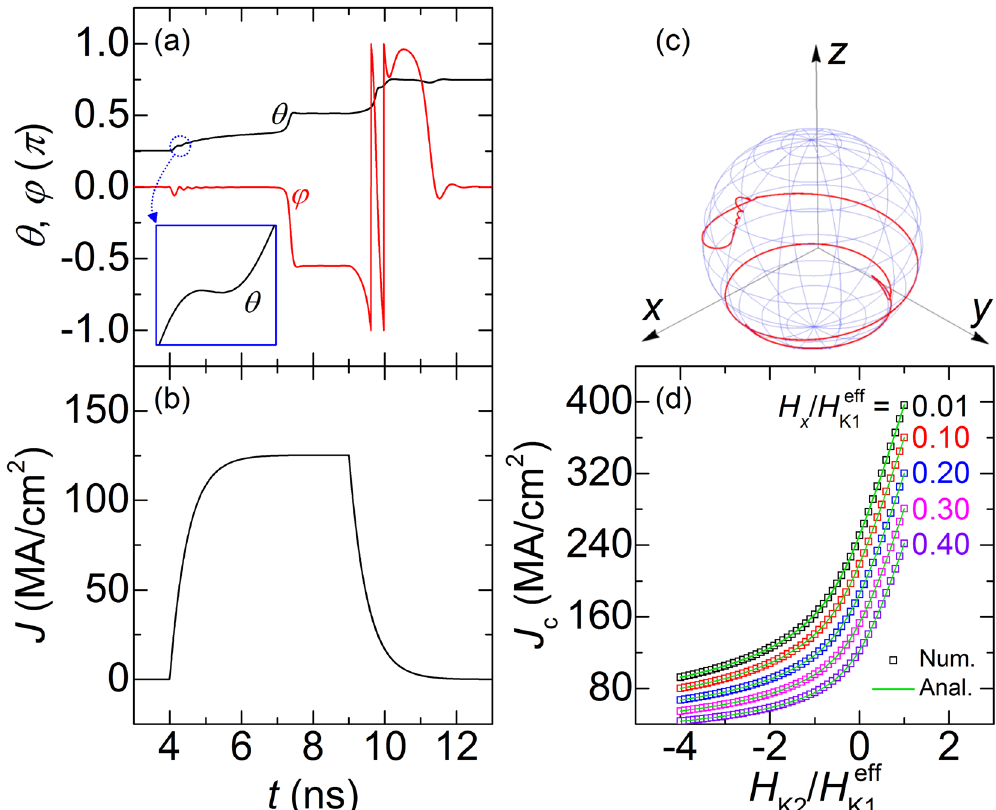
Figure 2. Macrospin simulation results for ( a ) temporal variations of θ (black) and ϕ (red) under applied pulse of J [in ( b )] and ( c ) 3D magnetization trajectory. The parameters used are H K1eff = 5 kOe, H K2 = − 10 kOe, H x = 0.05 kOe, M S = 1000 emu/cm 3 , α = 0.1, γ = 1.76 × 10 7 Oe − 1 s − 1 , θ SH = 0.3. The magnified results for the temporal variation of θ are shown in the inset of ( a ). ( d ) Results for J c as function of H K2 / H K1eff at various values of H x / H K1eff . Two sets of results are shown: one from the macrospin simulation (symbols) and the other from the analytical expressions derived in this study